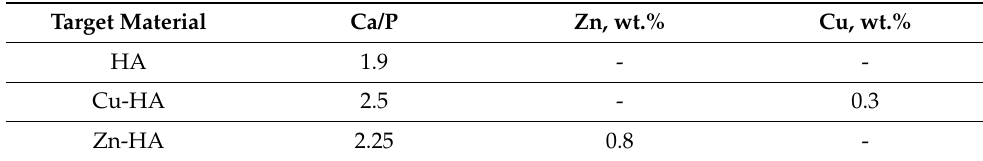
Table 3. Ca/P ratio and Zn and Cu content in CaP coatings.